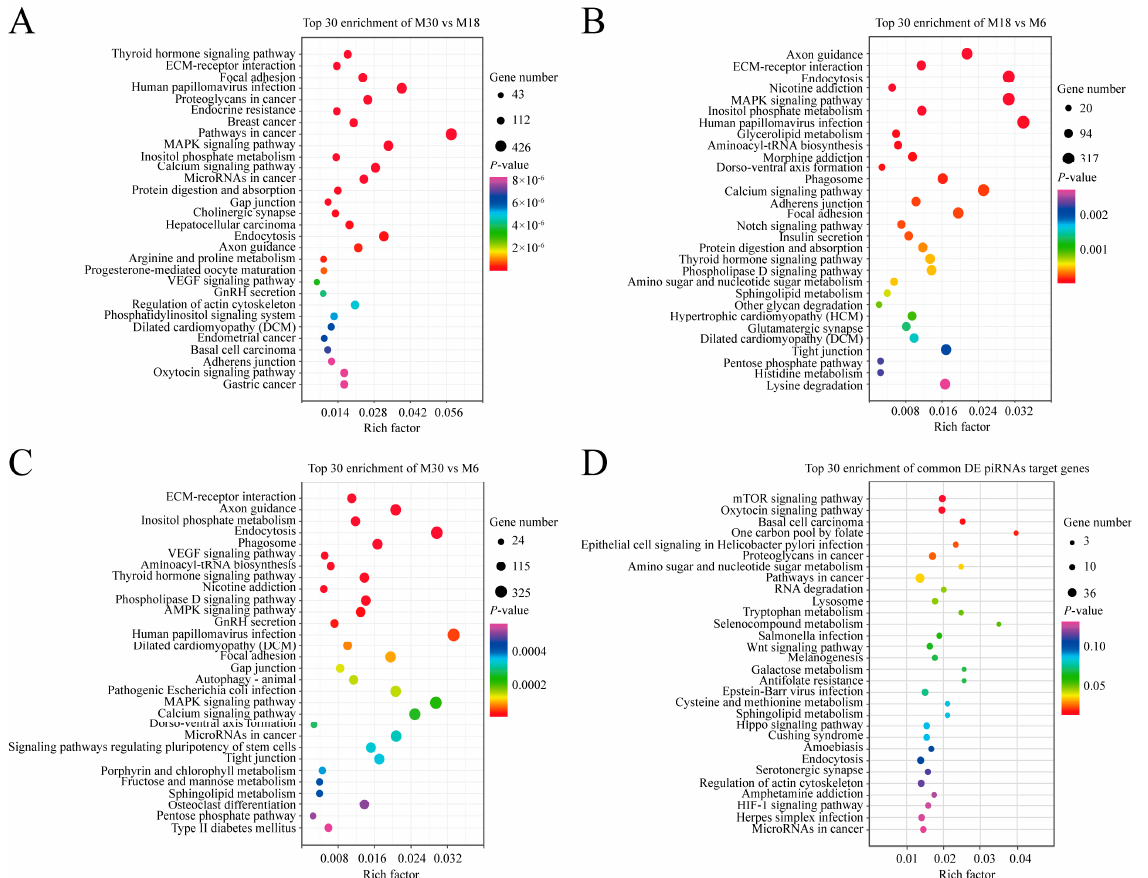
Figure 4. KEGG analysis of differentially expressed piRNA’s target genes. ( A ) KEGG analysis of differentially expressed piRNA’s target genes between M30 and M18; ( B ) KEGG analysis of differ- entially expressed piRNA’s target genes between M18 and M6; ( C ) KEGG analysis of differentially expressed piRNA’s target genes between M30 and M6; ( D ) KEGG analysis of common differentially expressed miRNA target genes; the vertical and horizontal axes represent the enrichment pathways and rich factors of these pathways, respectively. P-values of each pathway are color-coded.